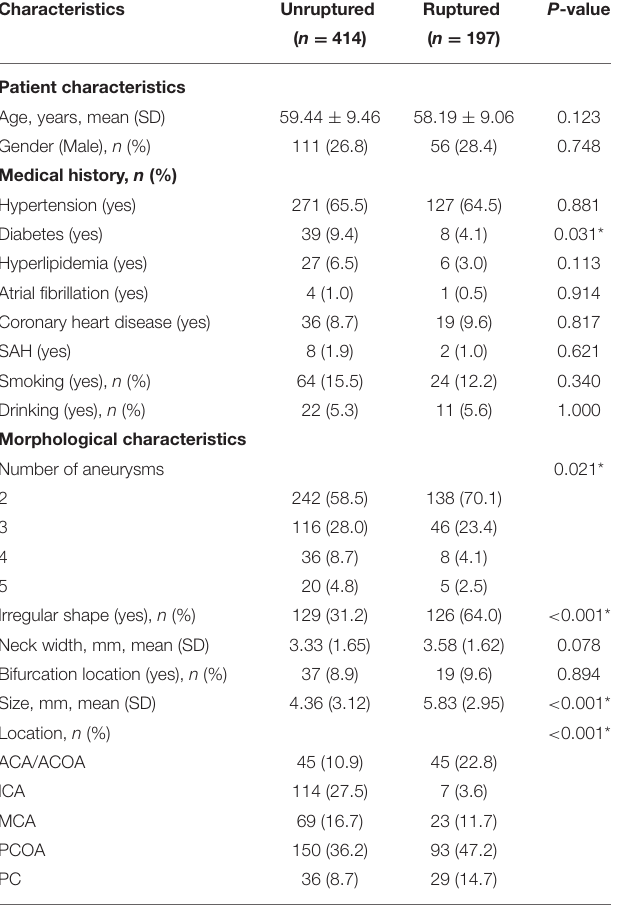
TABLE 1 | Univariate analysis of patient and aneurysm characteristics in the derivation cohort. Characteristics